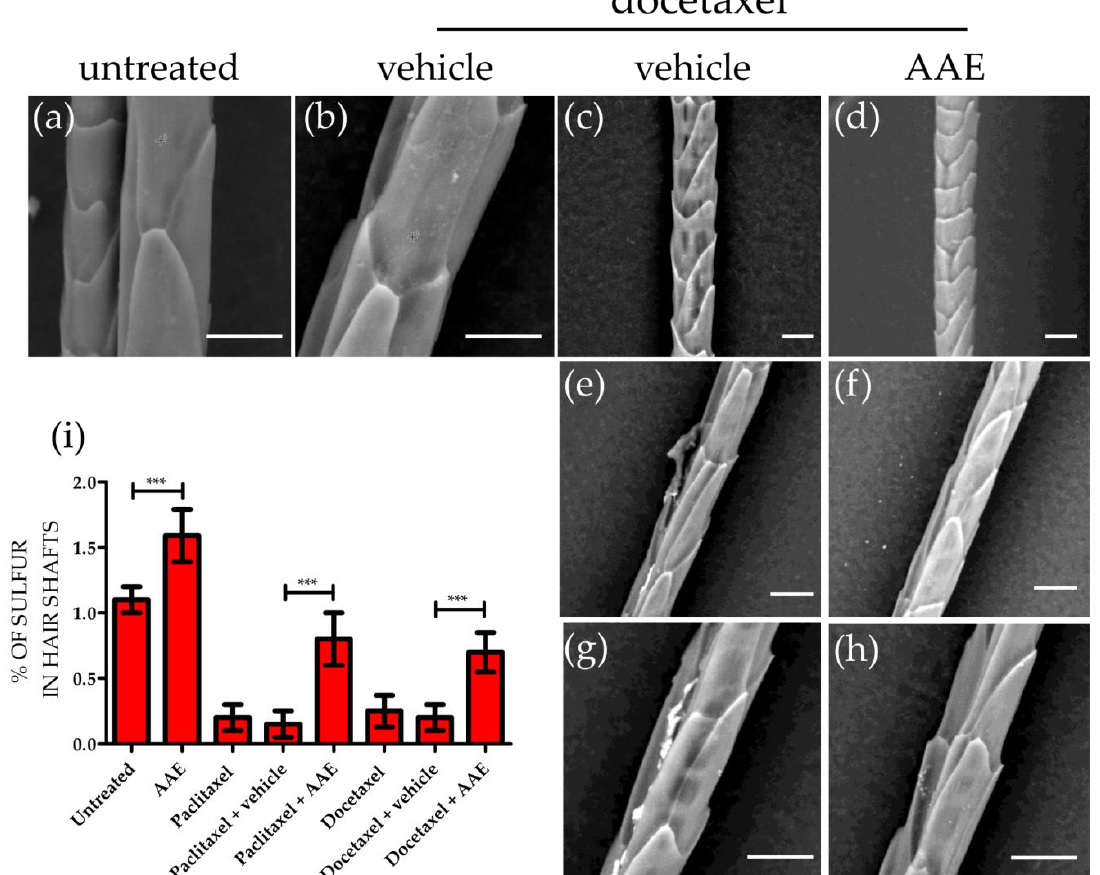
Figure 3. AAE preserves keratin content in murine HFs treated with taxanes. Hair shafts plucked out from mice biopsies treated as in Figure 2 were analysed by SEM-EDX. Morphology of hair shafts extracted from untreated skin biopsies ( a ) or treated with docetaxel (700 nM; b , c , e , g ) and showing signs of hair shaft damage. Morphology of hair shafts extracted from HFs treated with Docetaxel in the presence of AAE ( d , f , h ) showing signs of hair shaft protection exerted by AAE (Scale bars correspond to 10 µ m). ( i ) SEM-EDX quantitative analysis indicates a decrease in Sulphur content in hairs shafts extracted from HFs treated with taxanes. In the presence of AAE the Sulphur content of hair shafts is partially preserved (mean ± s.e.m.; n = 8, *** p < 0.001).